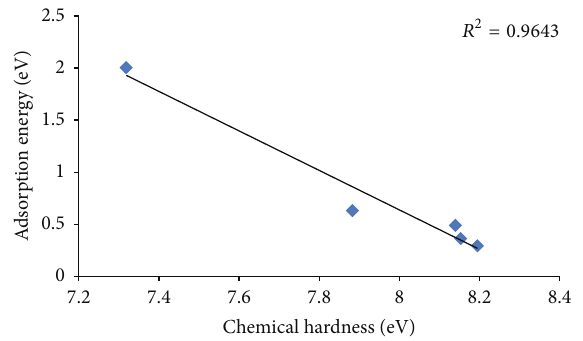
Figure 6: Linear correlation between the chemical hardness and adsorption energy.